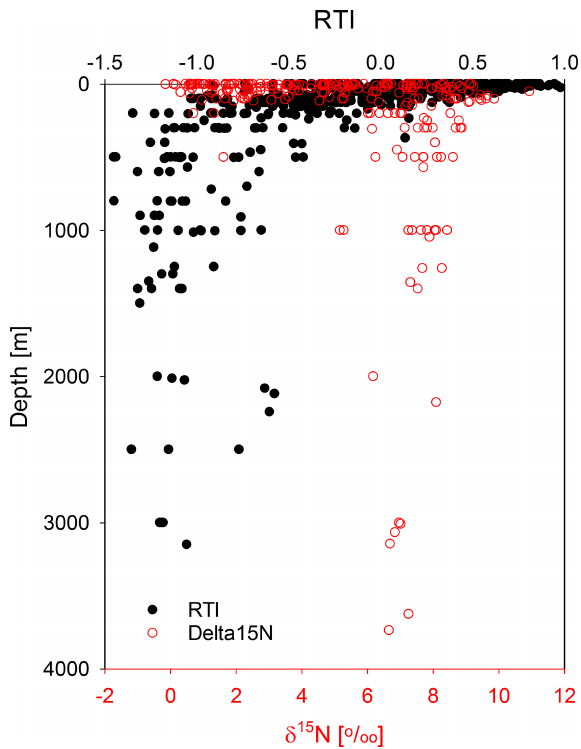
Figure 8. The RTI (black dots) and the δ 15 N values of SPM with water depths (m) (red